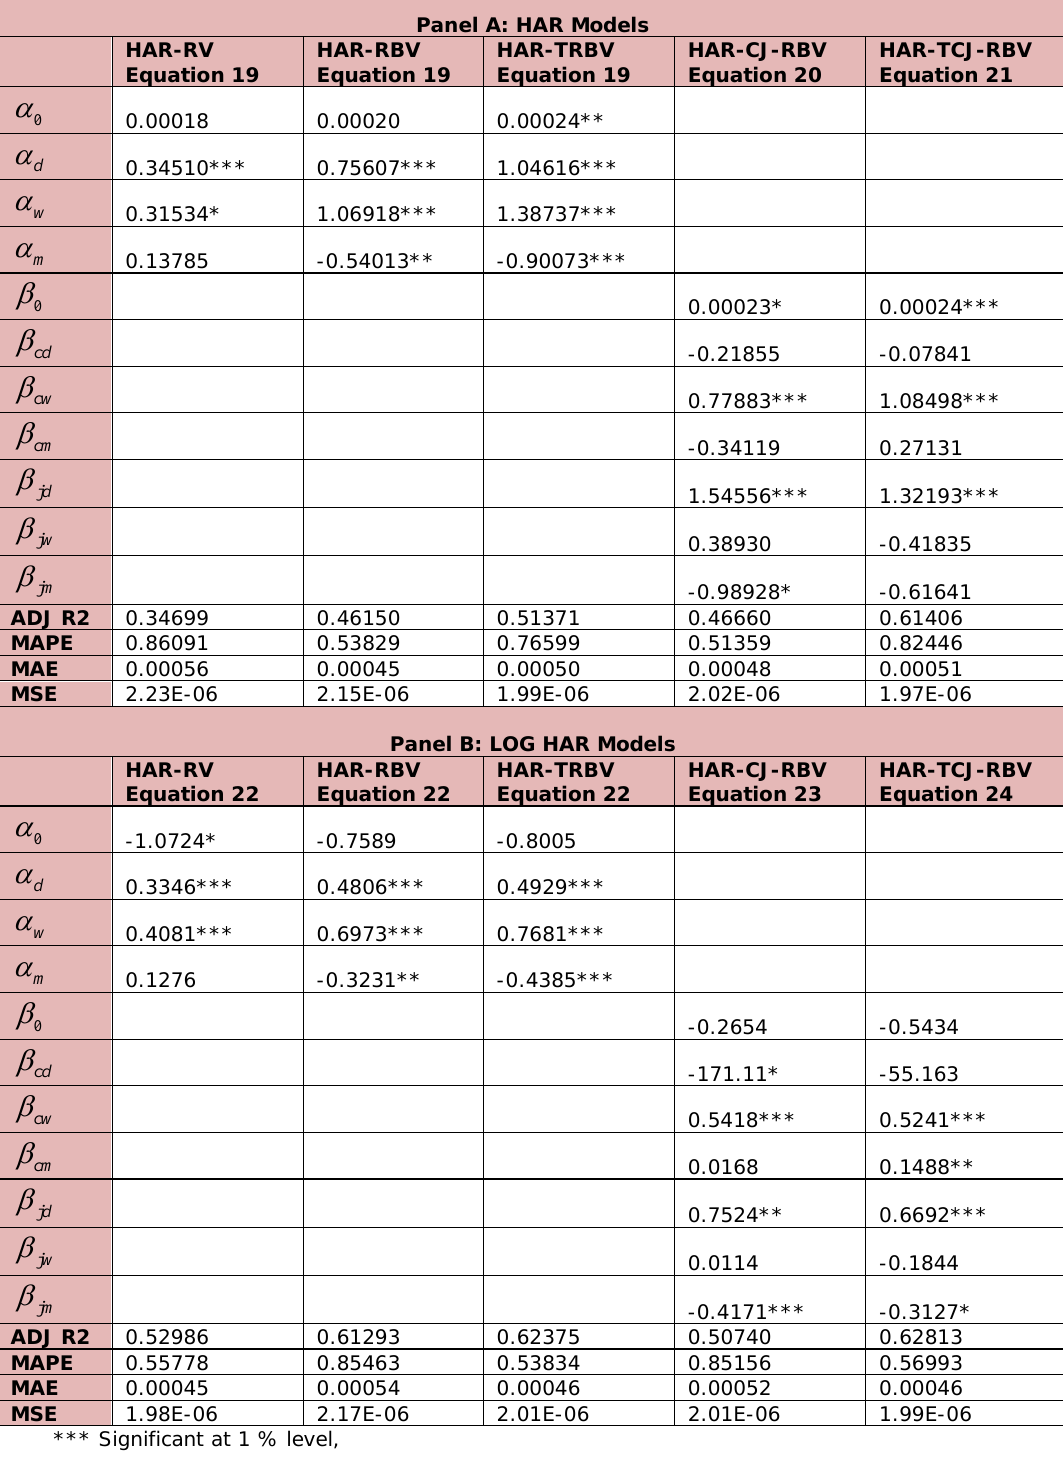
Table 3: “In-sample Prediction Accuracy”. Source: Own